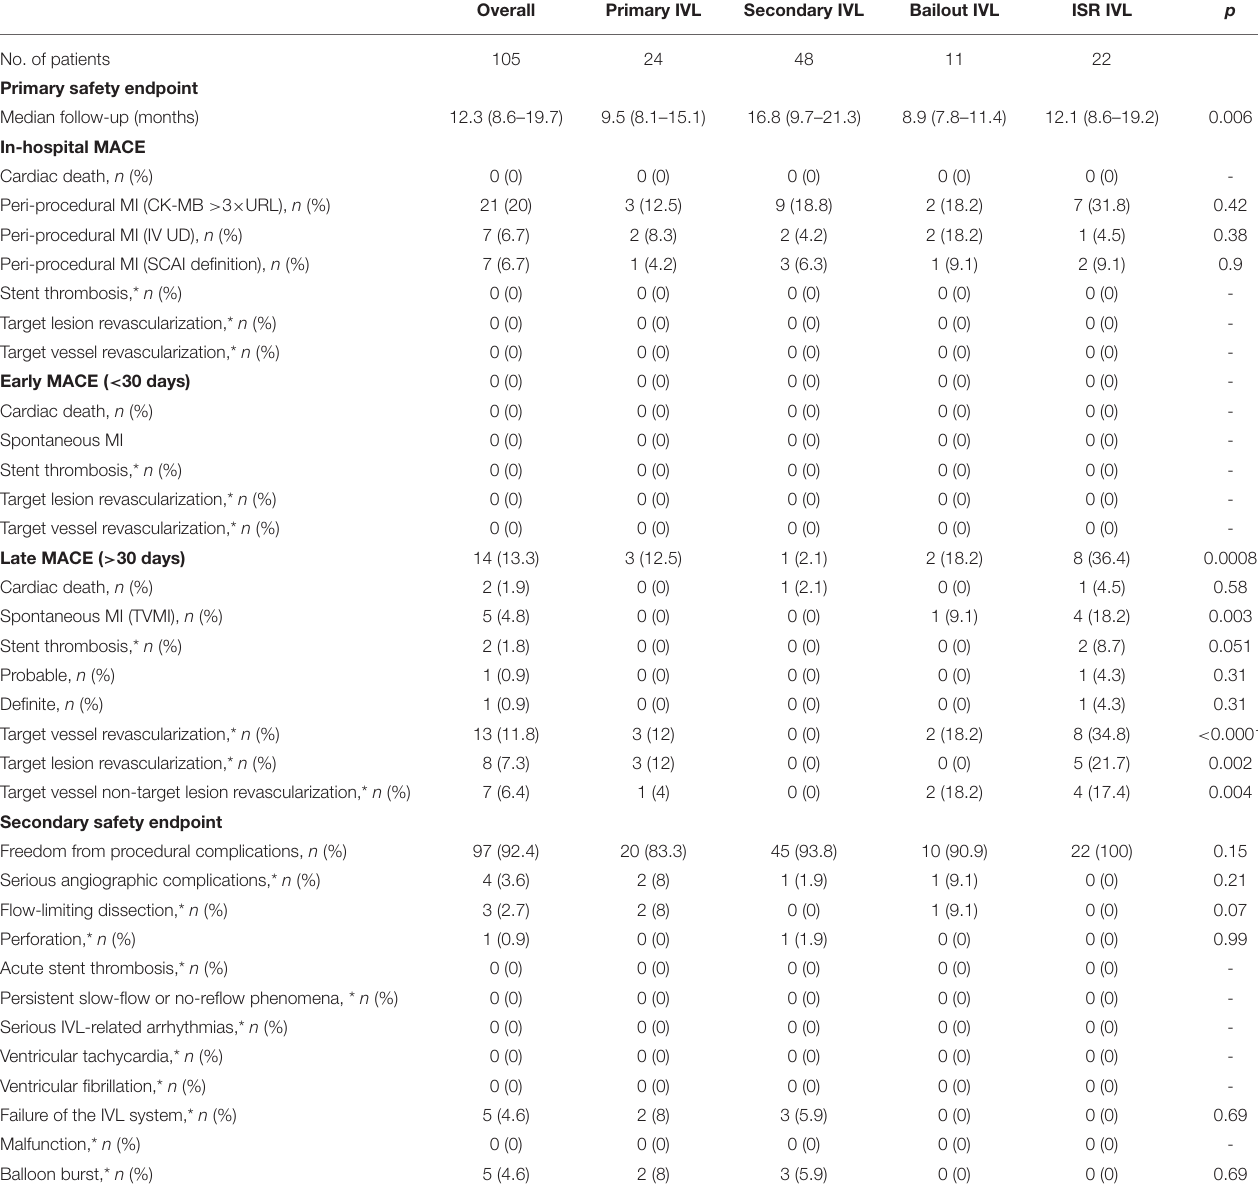
TABLE 6 | Safety endpoints in the overall population and patient